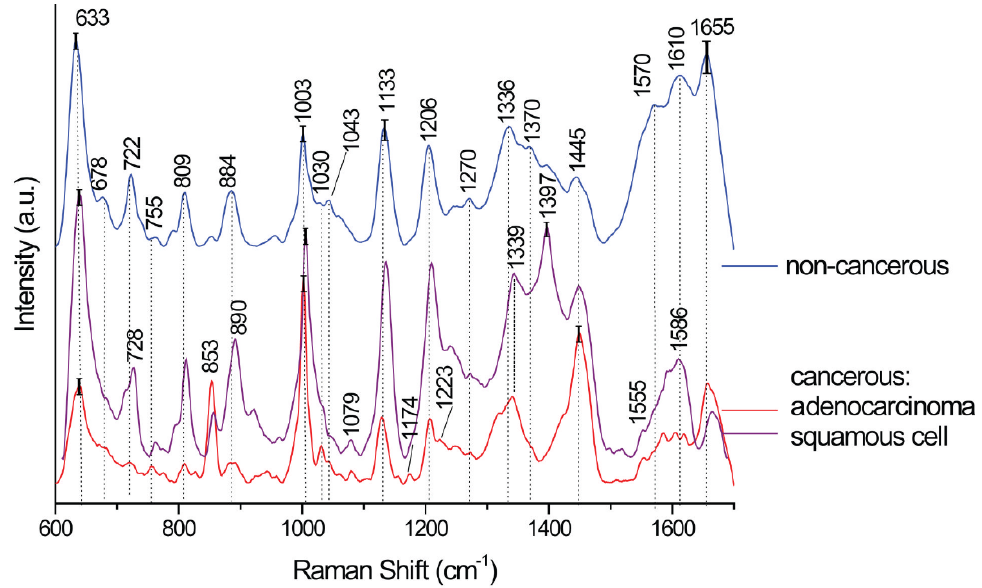
Figure 2. The averaged SERS spectra for non-cancerous and cancer samples for adenocarcinoma and squamous cell cancer. The bars present the SD of chosen bands.